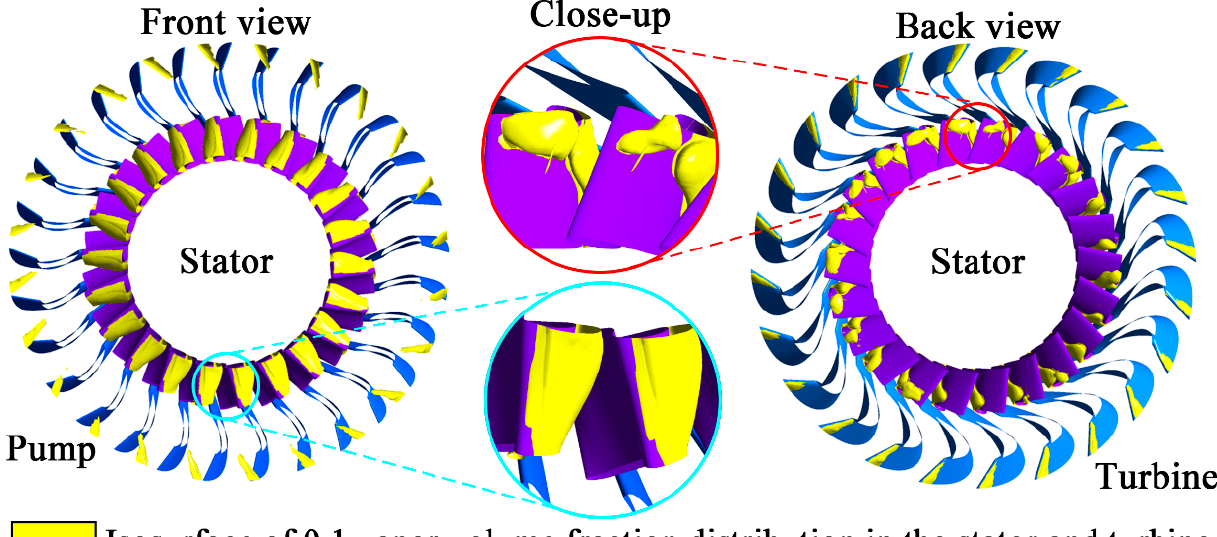
Figure 9. Unsteady cavitation in the stator ( left ) and the turbine ( right ) domain under SR = 0 condition.